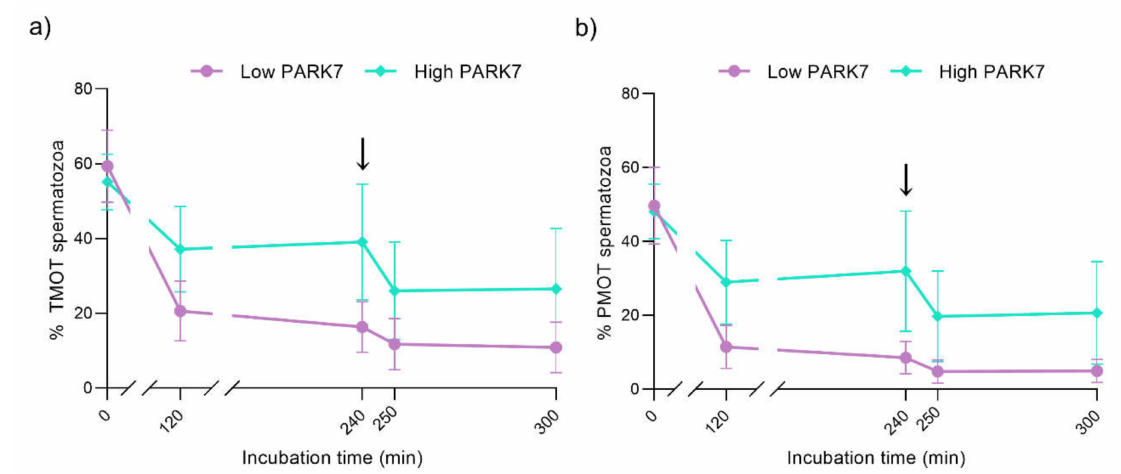
Figure 3. Percentages of total ( a ) and progressively ( b ) motile sperm during in vitro capacitation and acrosomal exocytosis induced by progesterone (300 min). The black arrows indicate the addition of progesterone at a final concentration of 10 µ g/mL (240 min). Data are represented as means ± SD. Abbreviations: TMOT, total motility; PMOT, progressive motility. Table 1. Values of kinematic parameters of two groups of sperm samples, clustered on the basis of their relative PARK7 con- tent at 0 min, during in vitro capacitation and progesterone-induced acrosomal exocytosis (0, 120, 240, 250, 300 min). Results are shown as means ± SD. VCL: curvilinear velocity; VAP: average path velocity; VSL: straight-line velocity; ALH: amplitude of lateral head displacement; BCF: beat cross frequency; LIN: linearity; WOB: wobble coefficient; STR: straightness.